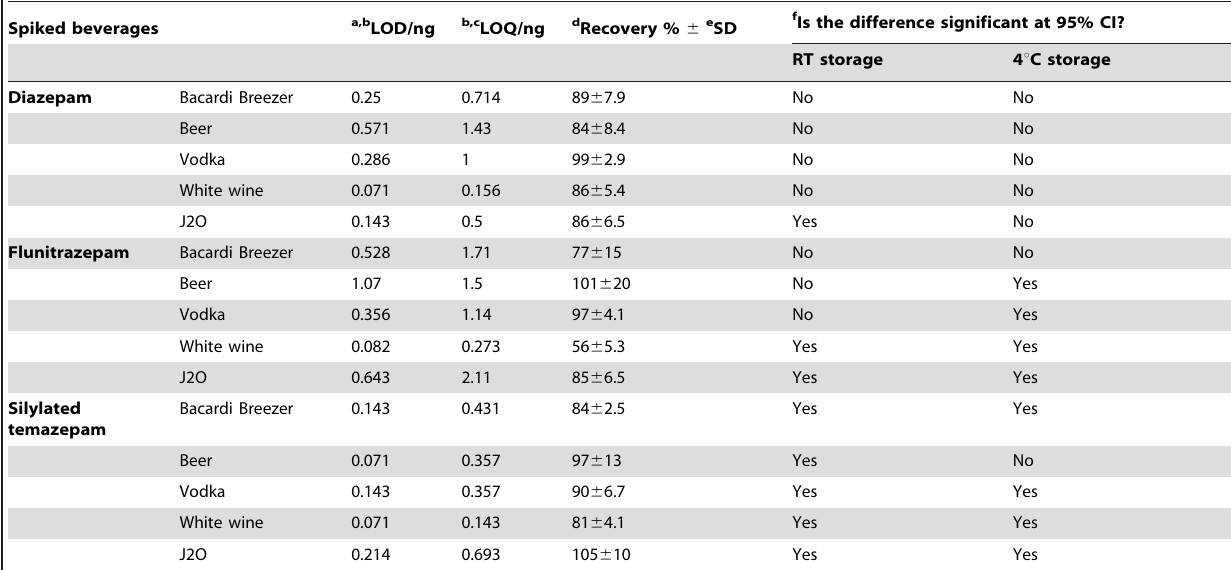
Spiked beverages